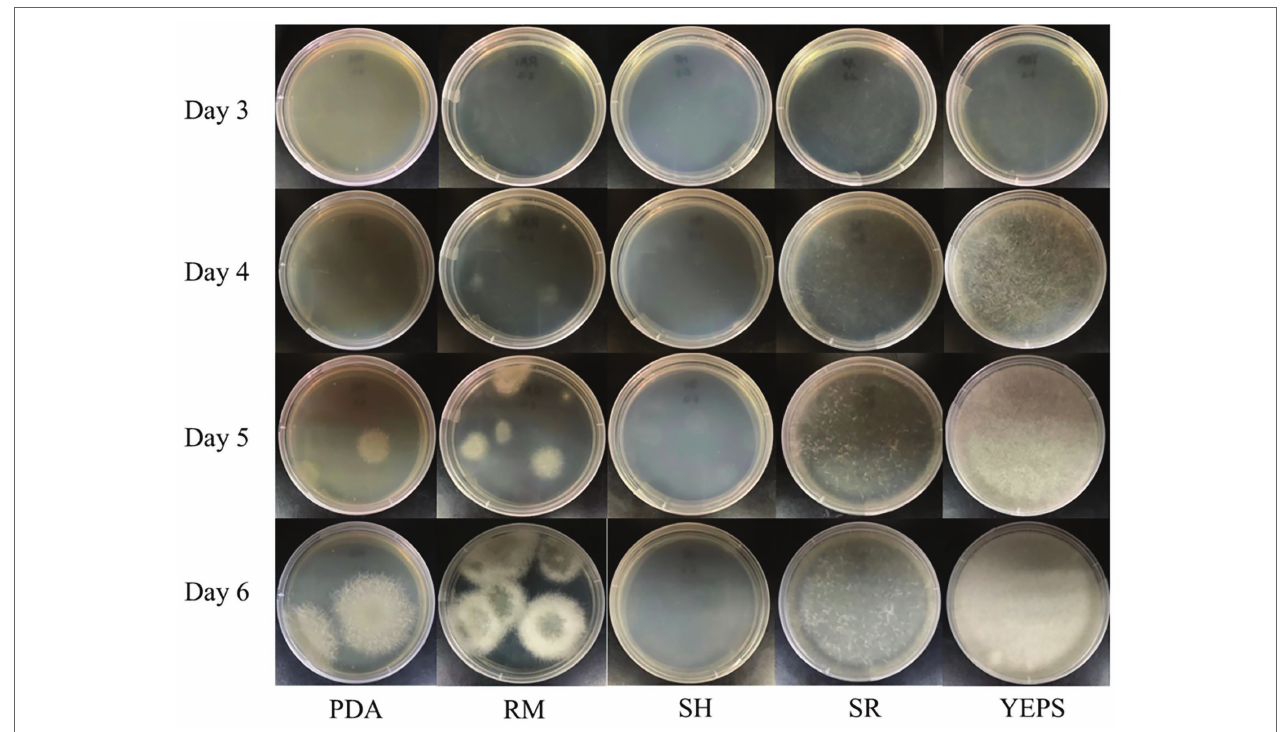
FIGURE 6 | Effect of strain D-1 protoplast regeneration in different regeneration